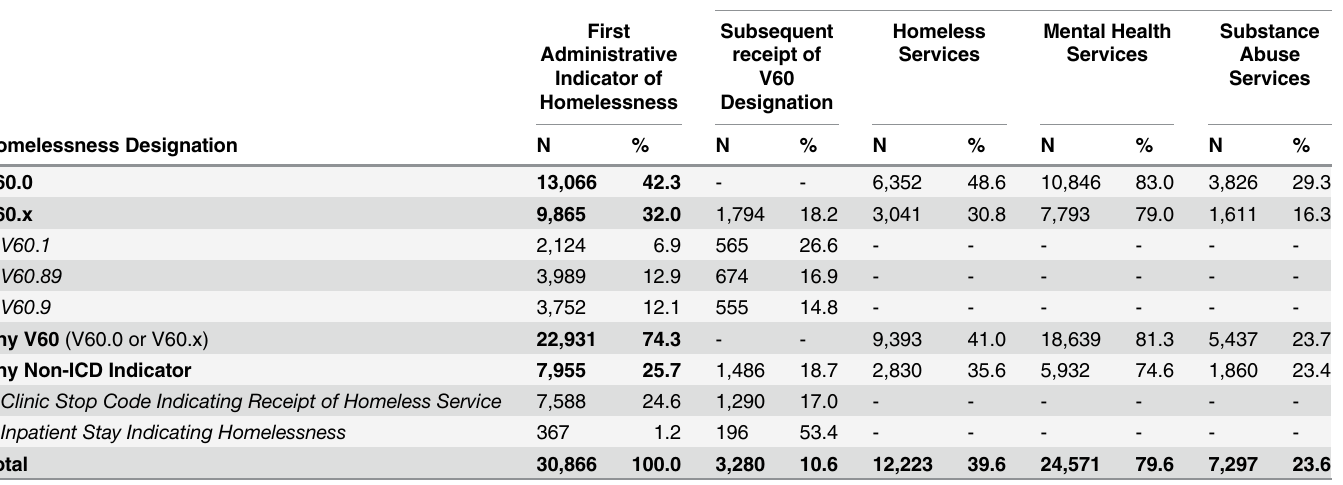
Table 3. Frequency of first administrative indicator of homelessness and receipt of V60.0 and outpatient services in the 90 days immediately fol- lowing the first administrative indicator among a cohort of OEF/OIF/OND Veterans during fiscal years 2001 – 2012. Note. ICD-9 codes V60.0 (lack of housing), V60.1 (inadequate housing), V60.89 (other specified housing or economic circumstance), V60.9 (unspecified housing or economic circumstances) and clinic stop codes 522 or 530 (Department of Housing and Urban Development VA shared housing program [HUD-VASH]), 528 (telephone/homeless mentally ill [HMI]), 529 (health care for homeless Veterans); 590 (community outreach to homeless Veterans), or inpatient homeless stays (28, homeless compensated mental health residential and rehab treatment program [(MH RRTP CWT/TR, treatment specialty]; 37, domiciliary care for homeless Veterans [DCHV, treatment specialty]).